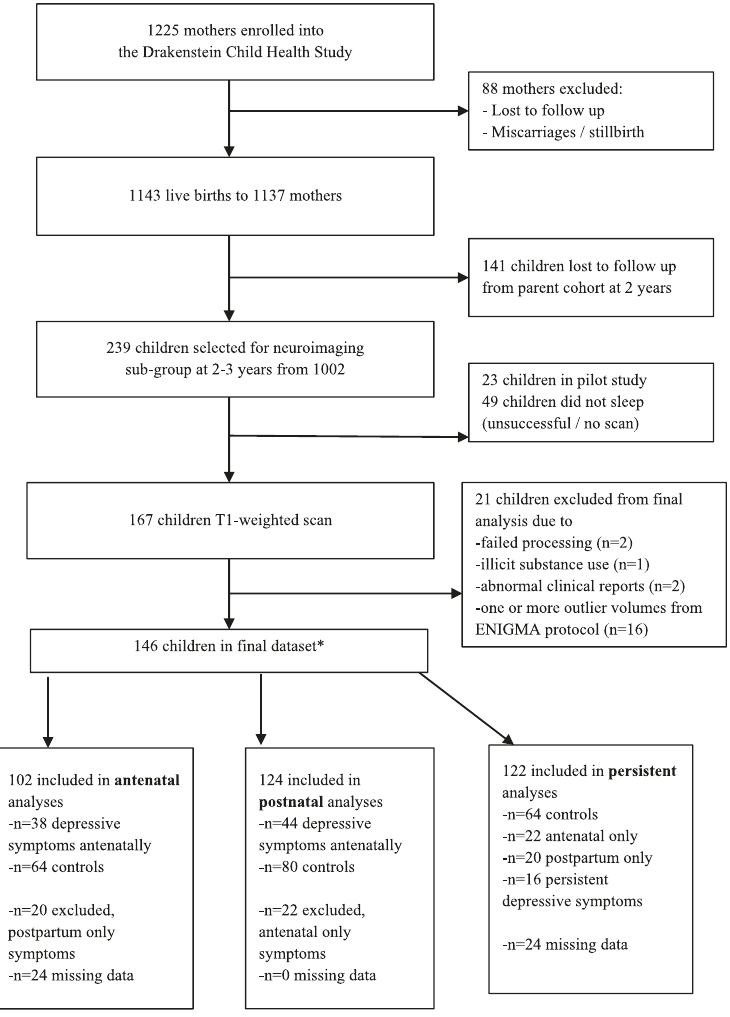
Fig. 1 Drakenstein Child Health Study and Neuroimaging sub-study consort diagram. It shows the fl ow of the study design and analytic samples in the present